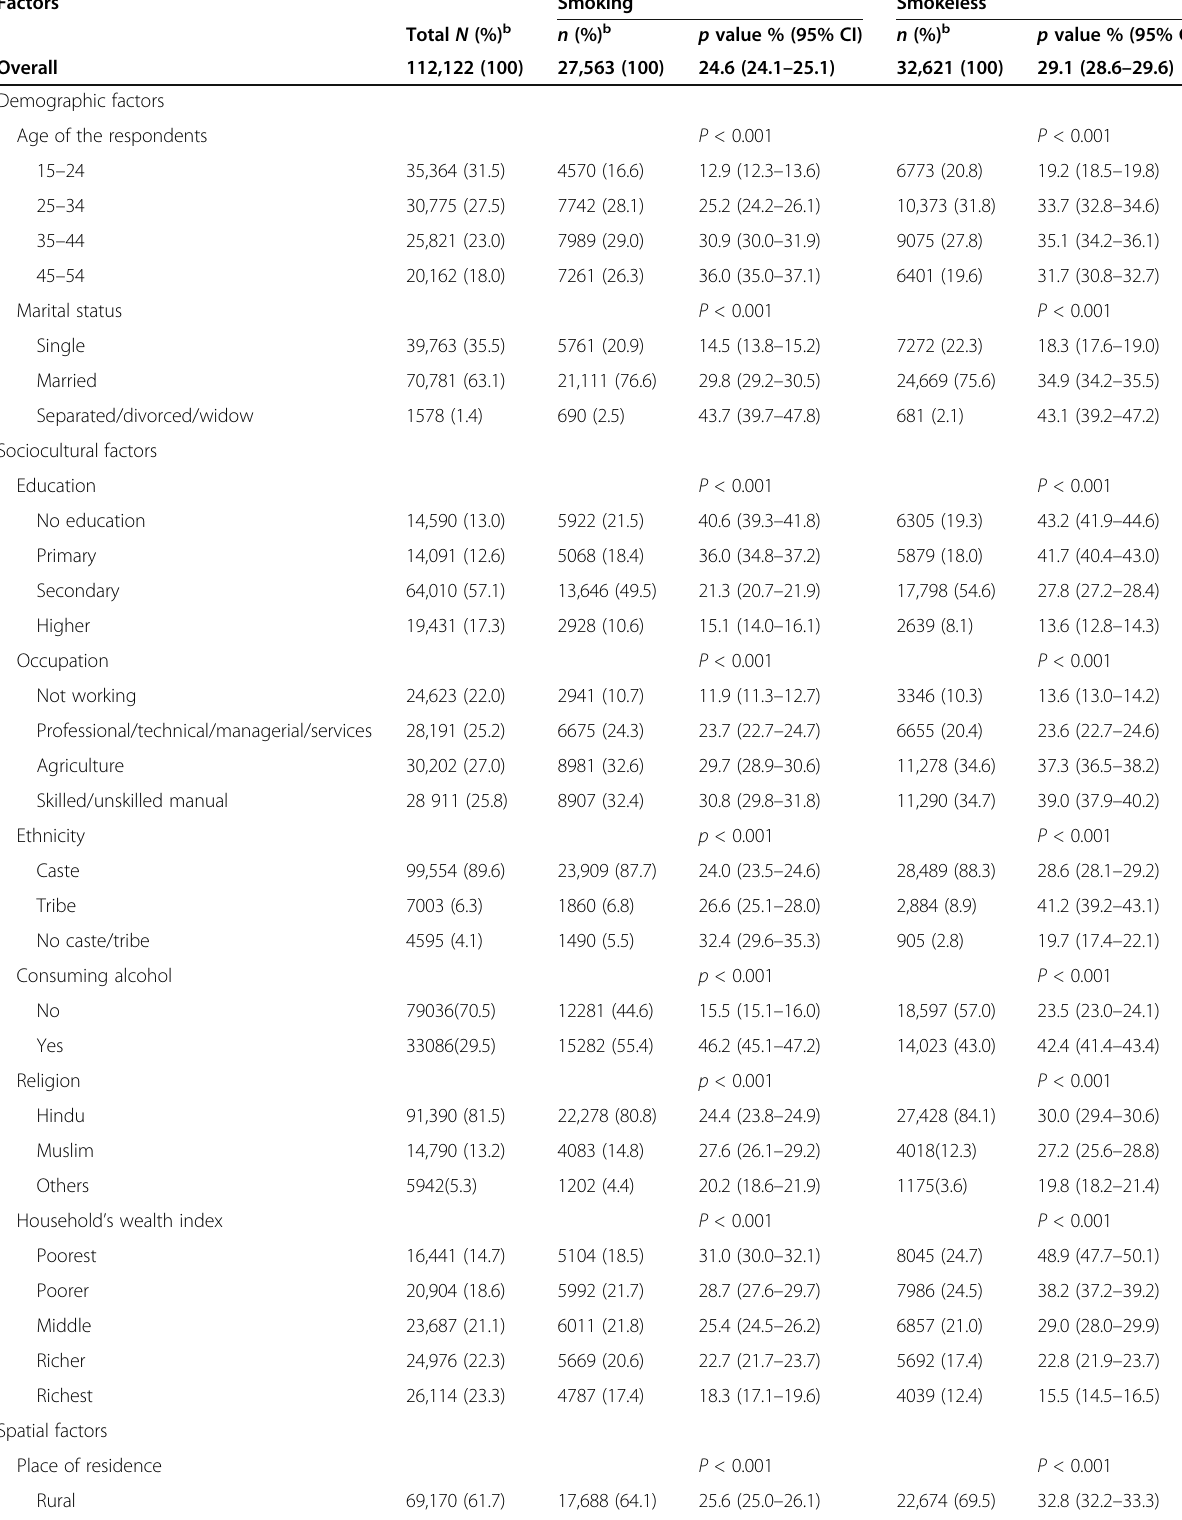
Table 1 Characteristics of the study population and prevalence of smoke and smokeless tobacco use among Indian men by socio- demographic characteristics, India 2015 – 2016